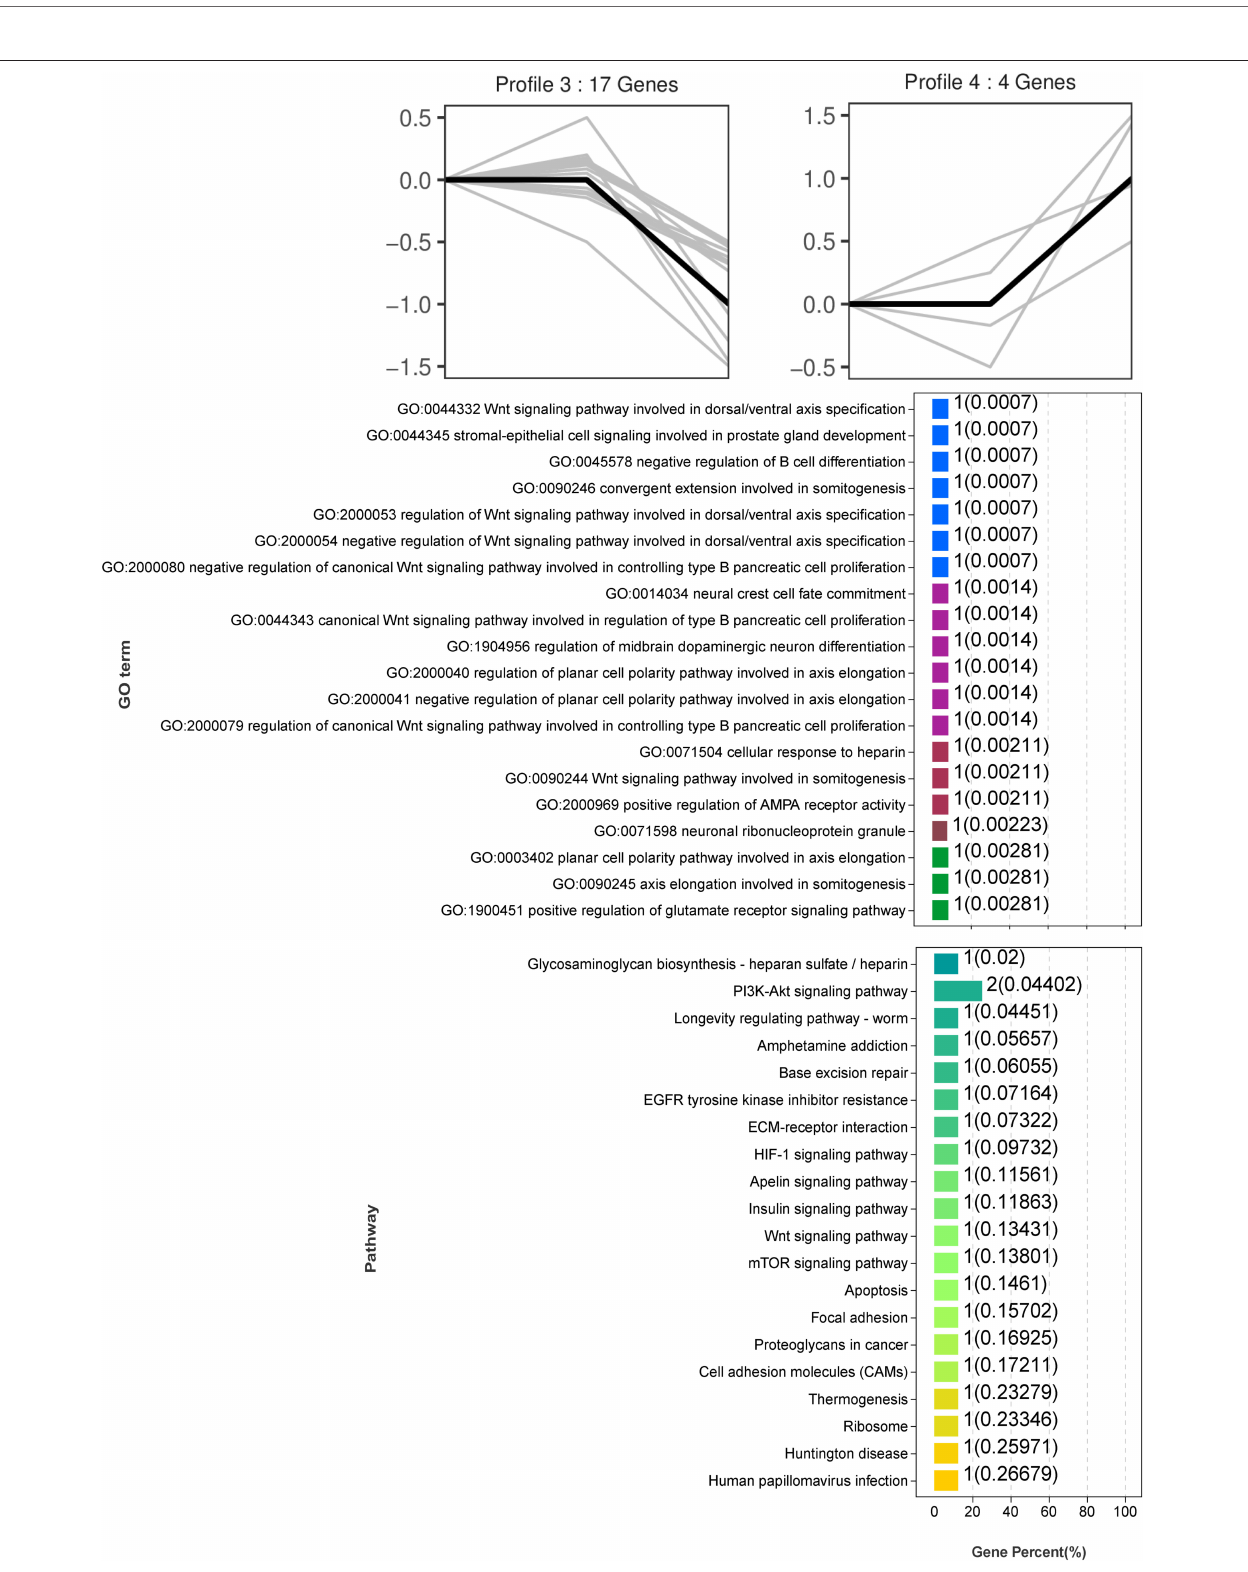
Frontiers in Veterinary Science |